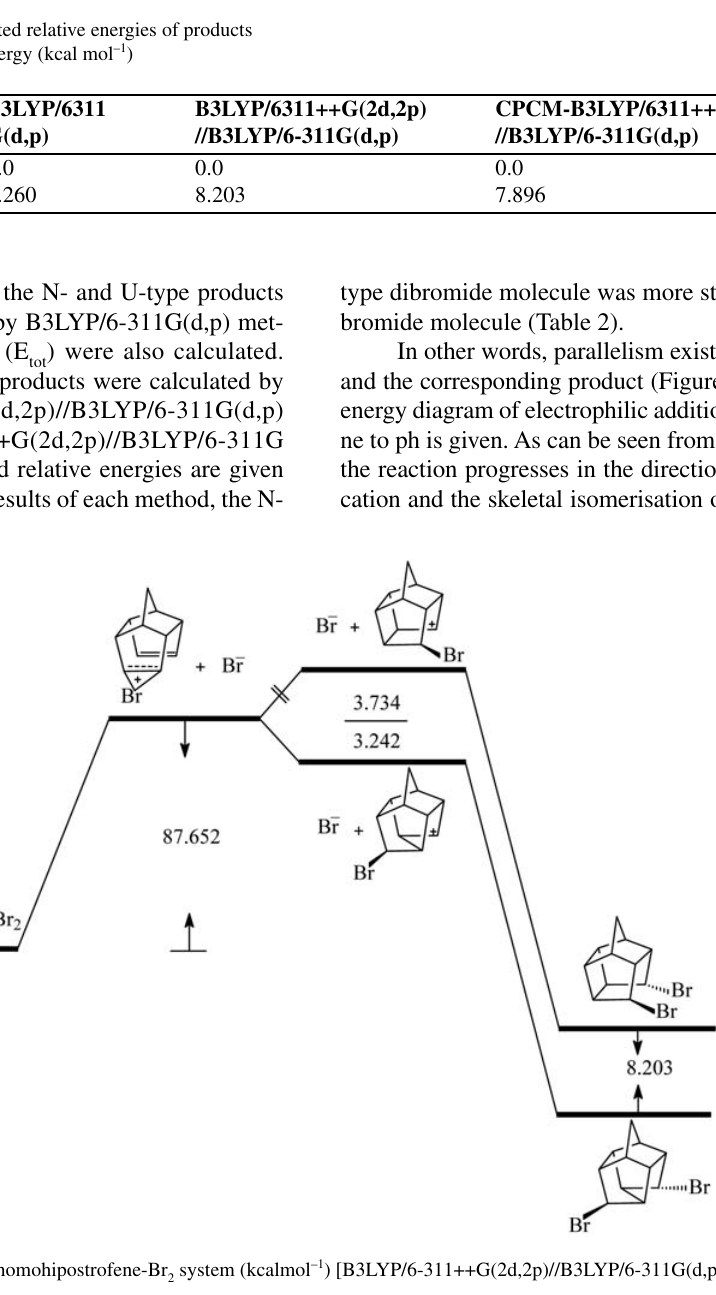
Figure 1. The energy diagram of homohipostrofene-Br